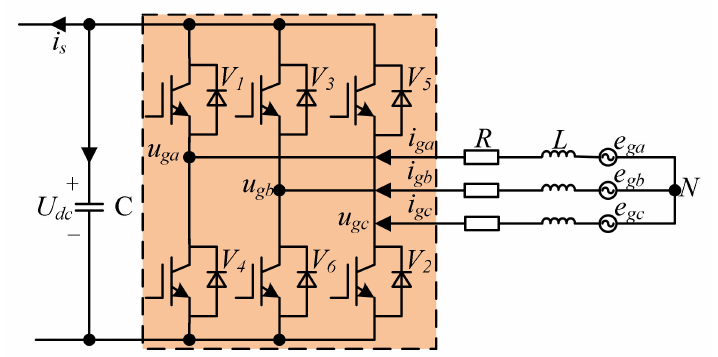
Figure 2. Topological structure of the grid-side